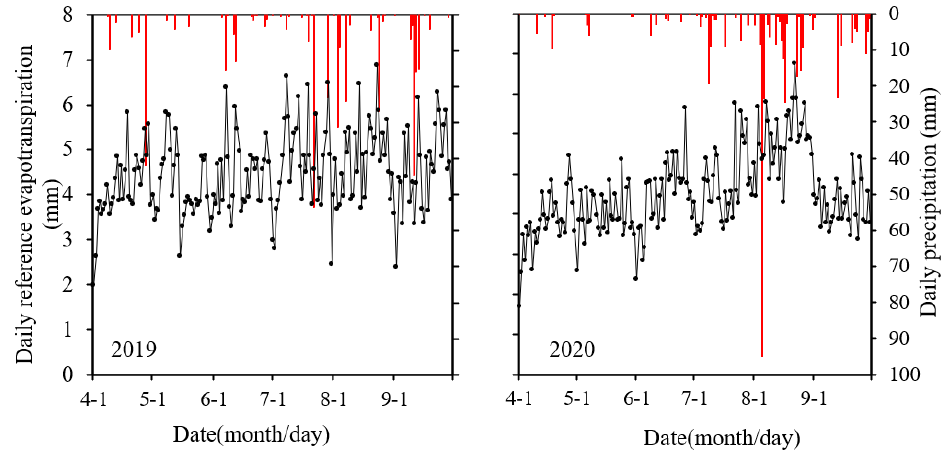
Figure 4. Dynamics of daily precipitation and reference evapotranspiration of apple orchards during the growth period in 2019 and 2020. Table 2. Variation of monthly precipitation (P) and monthly reference evapotranspiration (ET 0 ) of apples from April to September in 2019 and 2020.